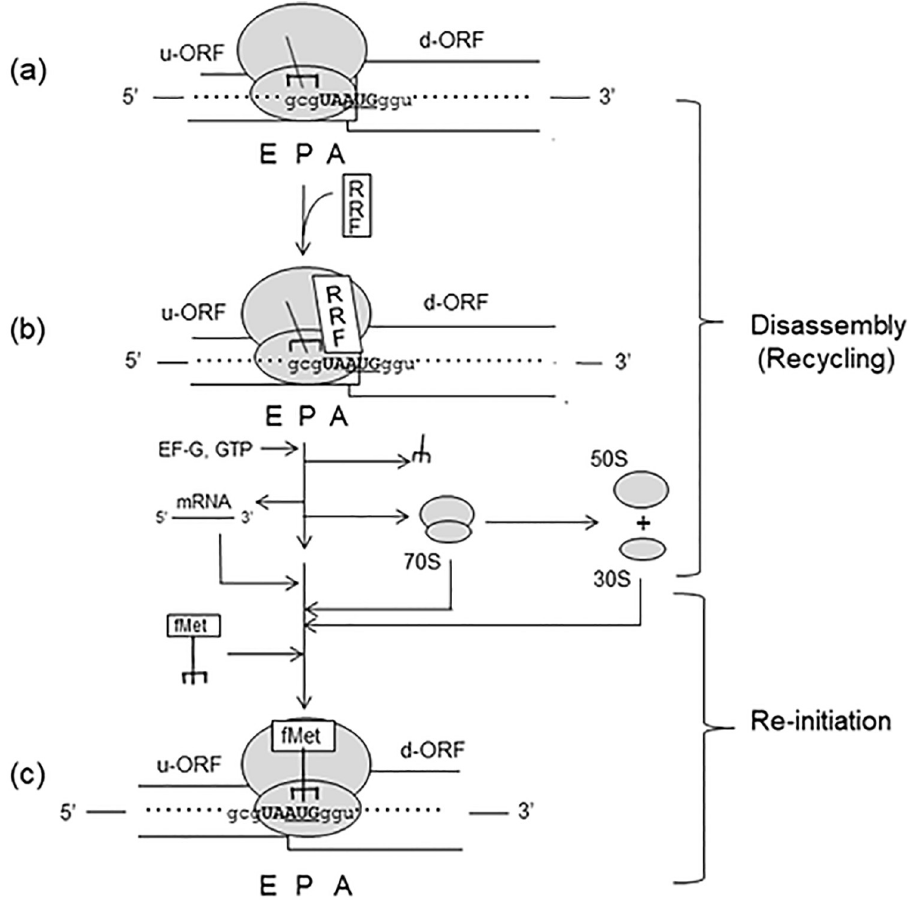
Fig 13. RRF’s function in translational coupling without SD. Complex (a); Post Termination Complex (PoTC) at the junction sequence of translationally coupled ORFs. The junction sequence UAAUG is shown in bold. Complex (b); RRF is bound on the ribosome at A/P-site. Complex (c); Completed 70S initiation complex. Process from (b) to (c); The ribosome and deacylated tRNA are released from the mRNA by RRF and EF-G action. The ribosome may or may not split into subunits. Both the 70S ribosomes and the ribosome subunits that engaged in the reading of the u-ORF may participate in downstream reading. The released 70S ribosomes or the dissociated ribosome subunits bind to the adjacent AUG on the same mRNA with the help of